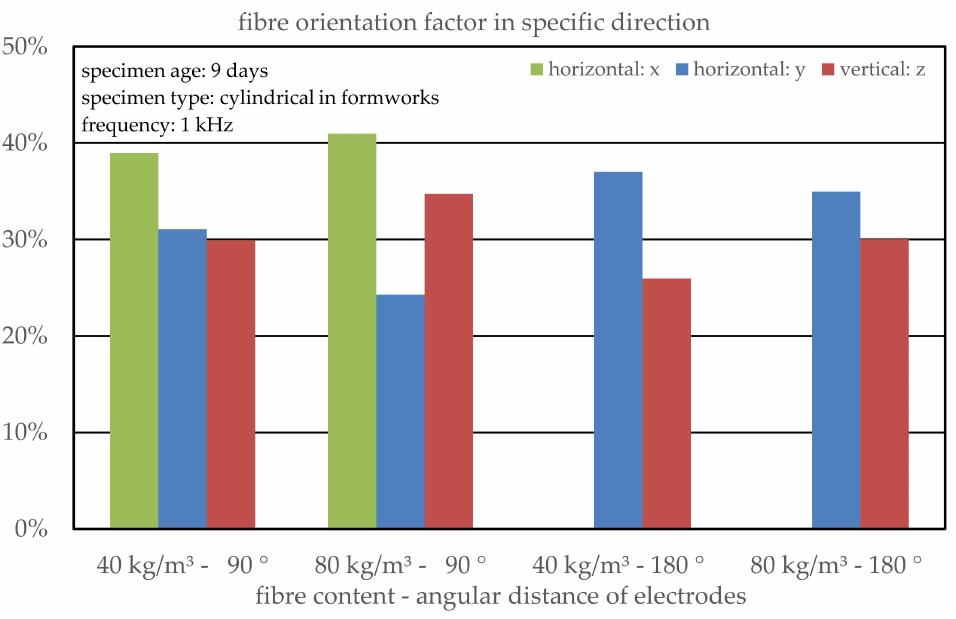
Figure 12. Calculated fibre orientation of the concrete specimens with different electrode arrays depending on fibre content at a specimen age of 9